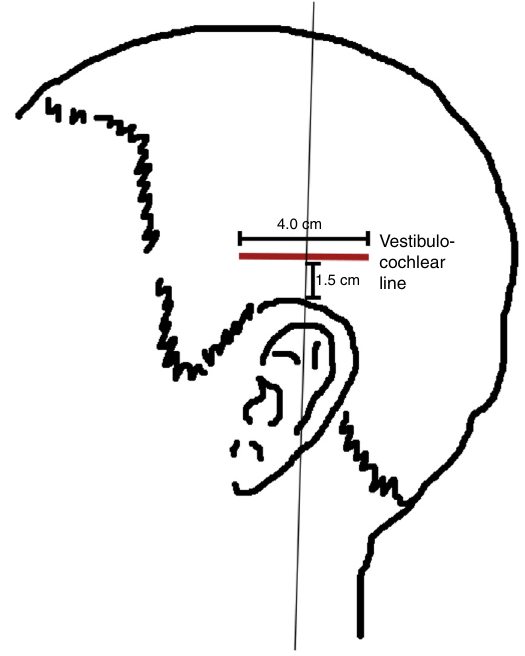
Vestibulocochlear line according to Chinese scalp